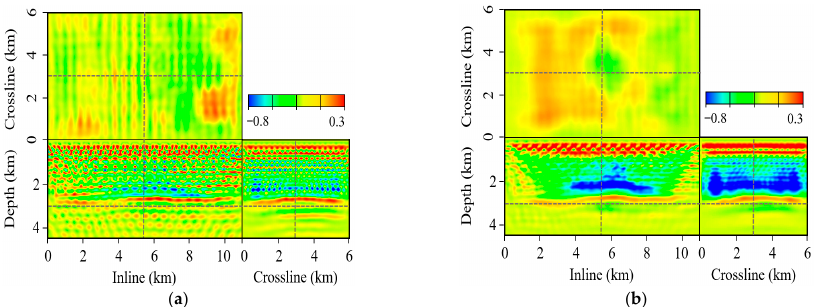
Figure 7. The first gradient direction of FWI using ( a ) mode I (conventional) and ( b ) mode IV (large- angle) of DAF.